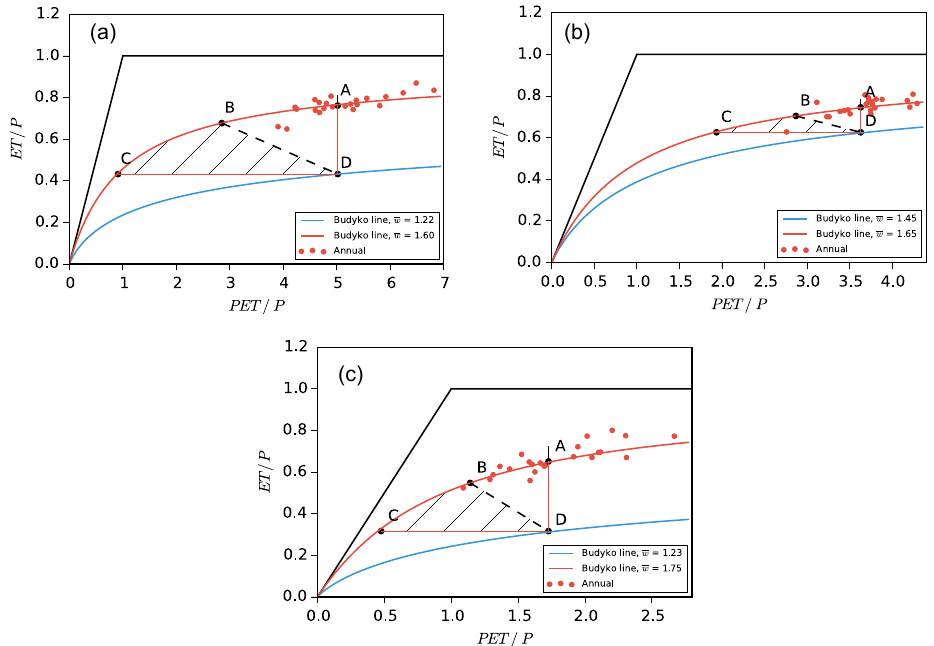
Figure 9. Budyko relation for three headwater catchments ( a , Yarkand; b , Hotan; c Aksu). The red points represent the values for each year; the P is obtained from the forcing, while ET and PET are obtained from the model. Point A represents the long-term average Budyko relation, and red lines are the optimal fitted Budyko line. The water input P , the potential evapotranspiration PET or the actual evapotranspiration ET can be modified to meet the observed discharge, which correspondingly shifts the representative points from A to B, C or D. B and C stay in the original Budyko curve, while a new optimal fitted Budyko curve through point D can be built after the changes in ET. The shaded area is the most likely area when not only a single variable is